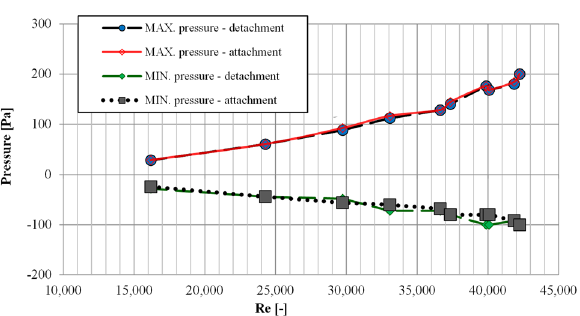
Figure 9. The minimum and maximum values of pressure p i for the examinations in the direction of detachment and attachment depending on the value of the Reynolds